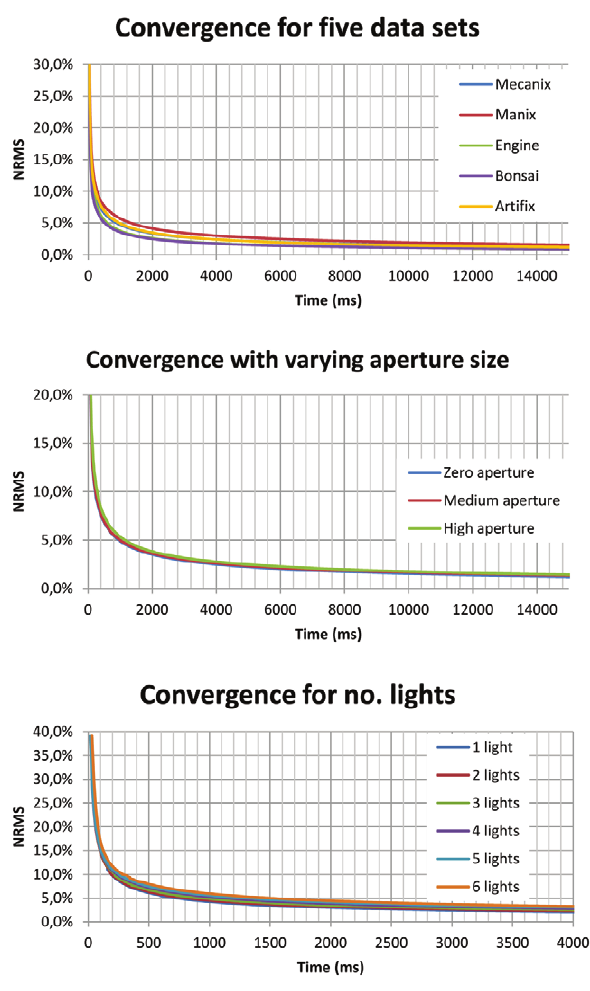
Figure 11. Convergence characteristics. Five typical data sets (top), Manix data set, with constant lighting and shading, subject to infinitely small aperture, medium aperture and large aperture respectively (middle) and the Backpack data set, with constant shading, camera parameters and increasing number of lights (bottom).